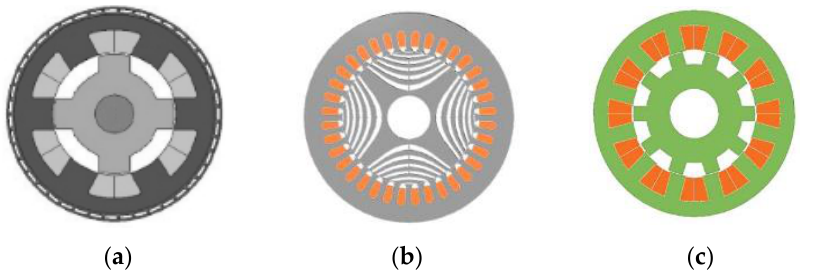
Figure 5. Cross-section of different motor cores: ( a ) induction; ( b ) synchronous reluctance; ( c ) switched reluctance [39,47].